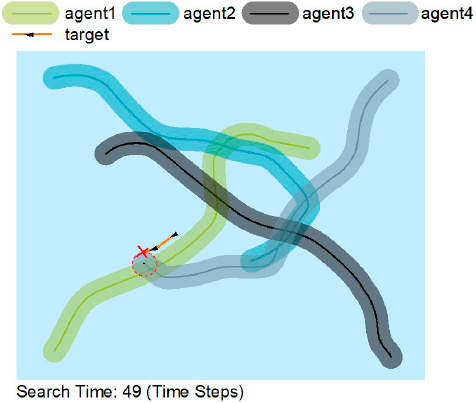
Figure 5. Search paths for the MATSMI algorithm.